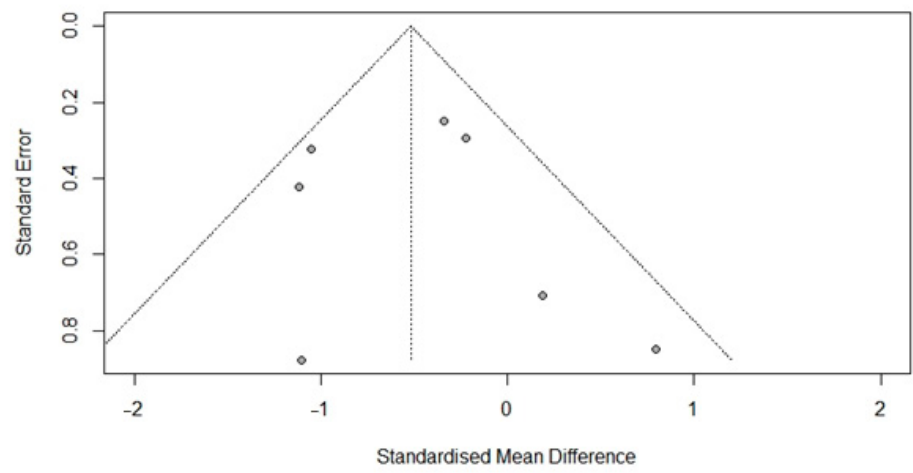
Figure 5. Funnel plot of full-scale intelligence scores in the BMD